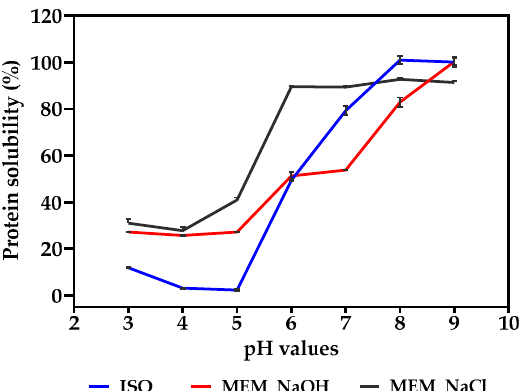
Figure 5. Percentage solubility at pH 3.0–9.0 of isoelectric pH precipitated isolate (ISO), and mem- brane isolates using alkaline (MEM_NaOH) and salt (MEM_NaCl) solution extracts.